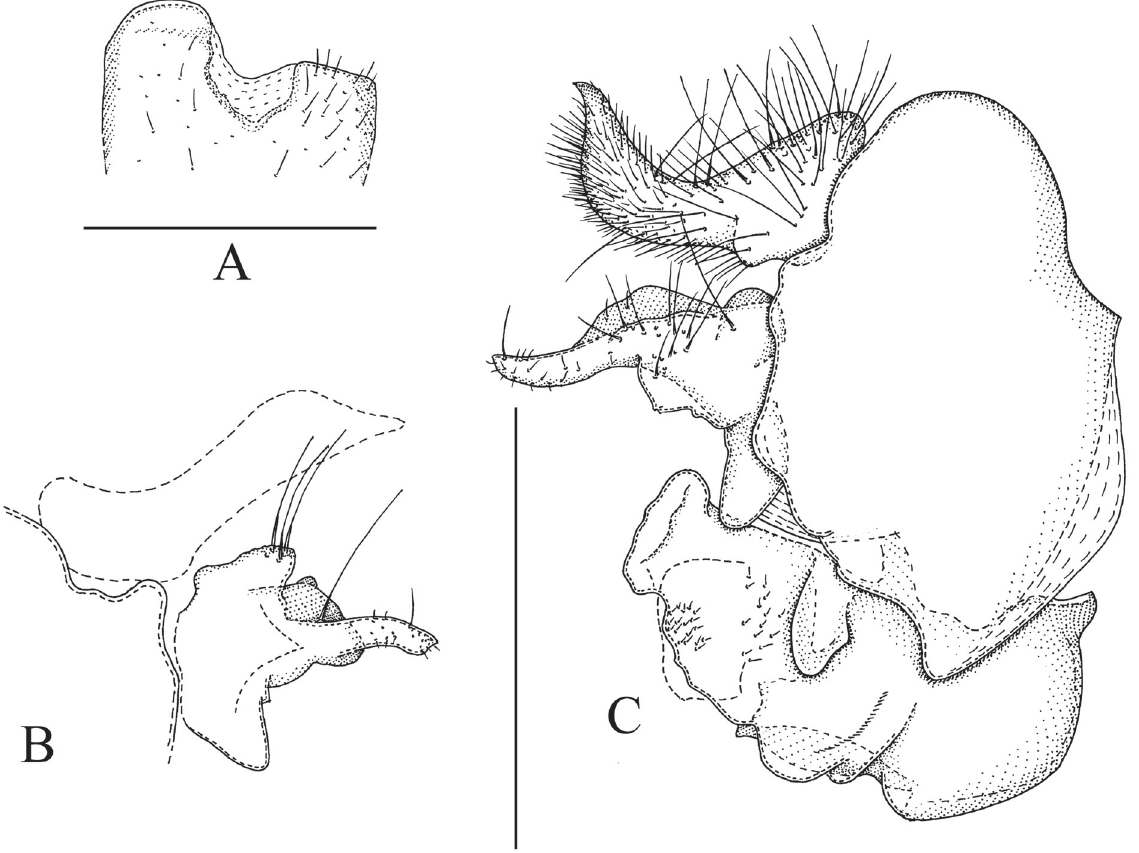
Fig. 92. Sphegina (Asiosphegina) umbrosa sp. nov., holotype, ♂ . A . Posterior part of sternum IV, ventral view. B . Left cercus and surstylus, latera l view. C . Genitalia, right side, lateral view. Scale bars = 0.5